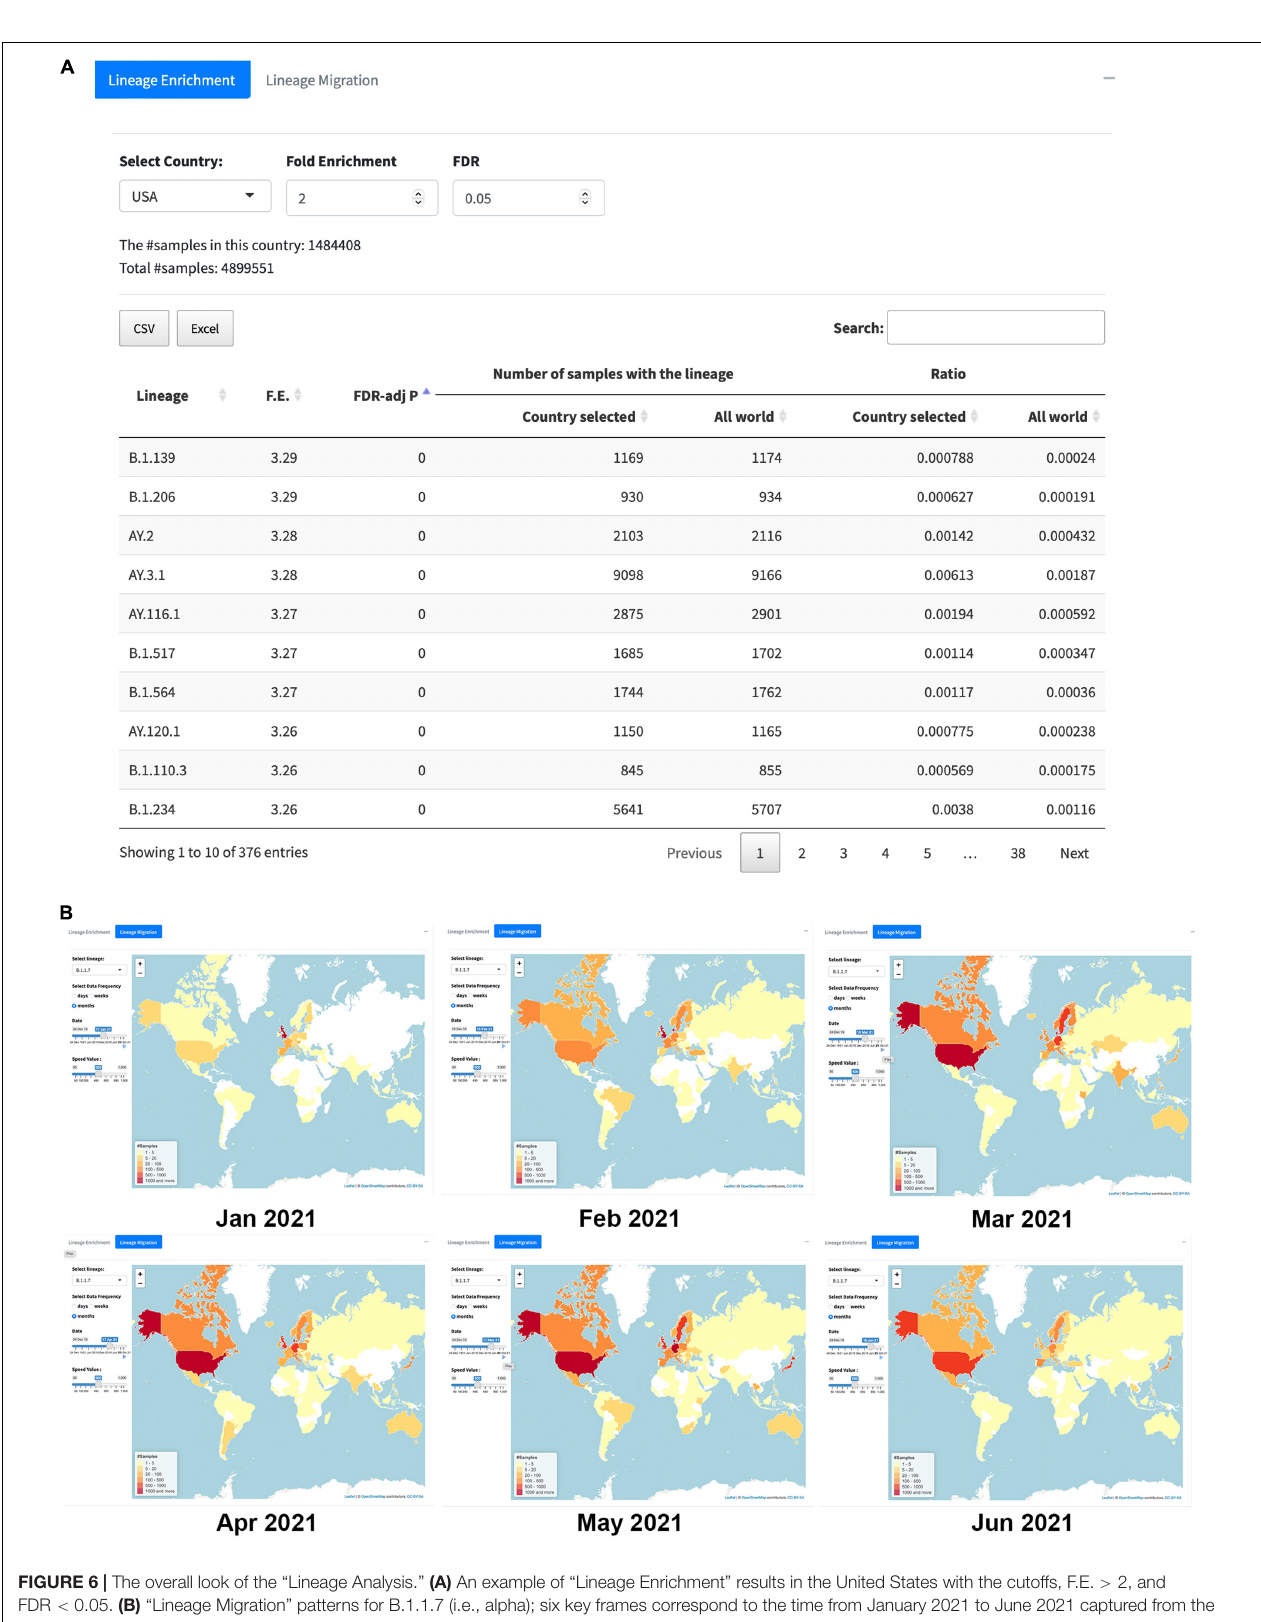
Frontiers in Medicine |